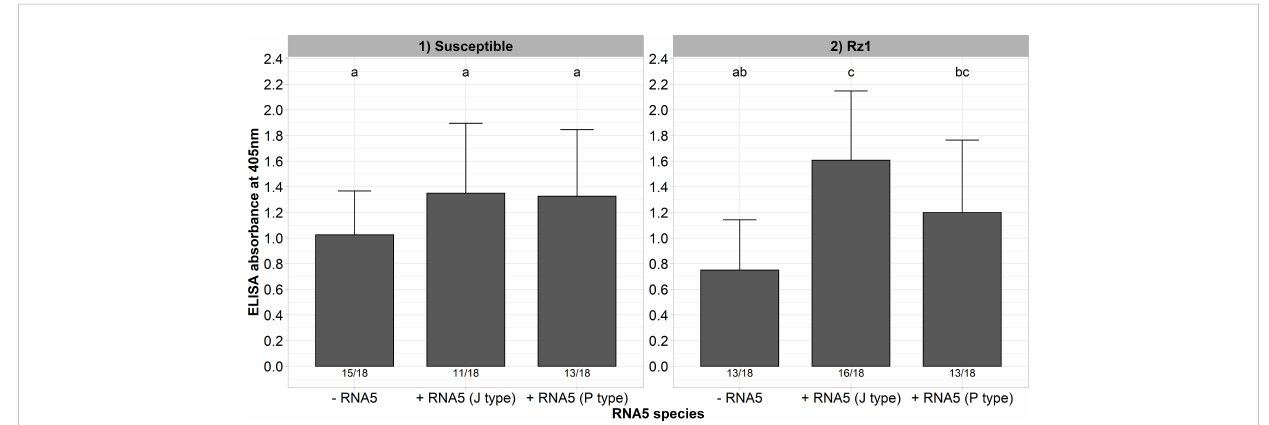
FIGURE 5 ELISA absorbance values for BNYVV measured in lateral roots of plants from a susceptible and Rz1 resistant sugar beet genotype (N=18). The resistance-breaking clone with the tetrad AYPR was either inoculated alone (-RNA5) or together with the P or J type RNA5 (+ RNA5). Lateral roots were harvested 6 weeks after infection. The numbers below each bar indicate the infection rate (infected/inoculated). Mean values were calculated using only infected plants, whereas all values were averaged when no plant was infected. Error bars indicate standard deviation. The healthy controls are not shown because the absorbance values were zero. The statistical analysis was done separately for both genotypes with the Dunnett post hoc test. Signi fi cant differences are indicated by small letters (p < 0.05).